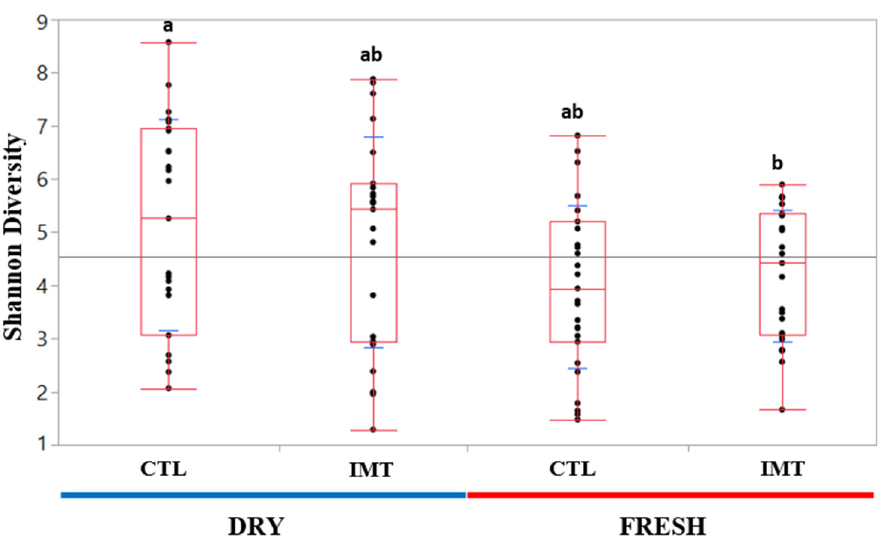
Figure 3. Shannon diversity quantile box plots for each treatment group for each sampling time point. Data were not normally distributed (Shapiro–Wilk p value = 0.044). Different letters (a and b) indicated treatment groups that had significantly different values based on Wilcoxon Sum Rank Test ( p value < 0.05). Fresh: samples collected from post-partum cows between 4 and 11